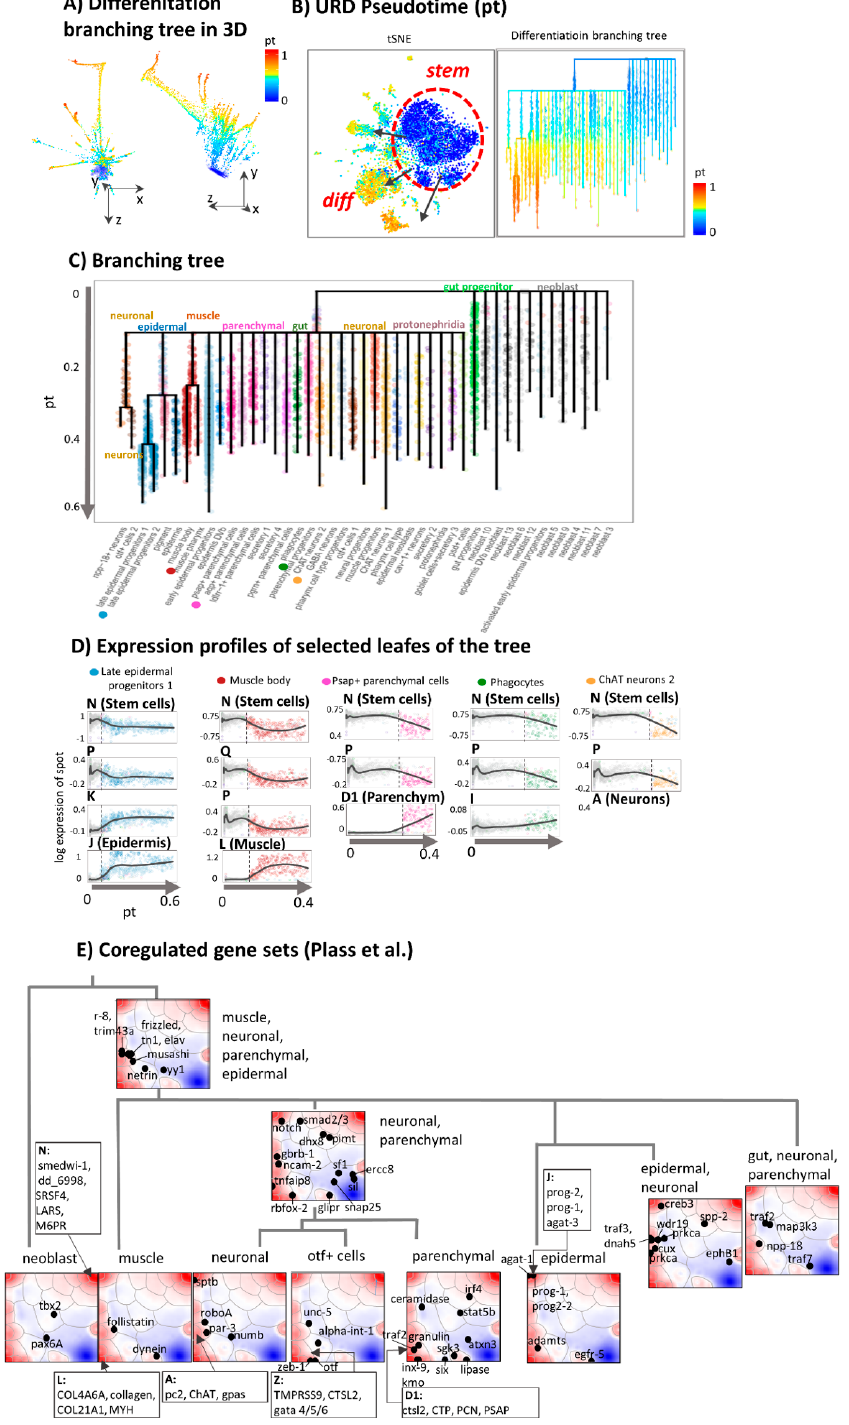
Figure 5. Branched pseudotime analysis of planarian tissue development. ( A ) URD plot [40] of branched di ff erentiation in 3D is shown in two projections. The pseudotime is calculated as the